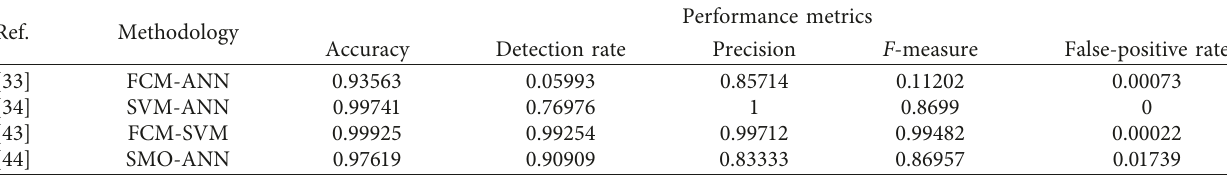
Table 5: Comparison of various methodologies based on different performance metrics for backdoor attack. Ref.